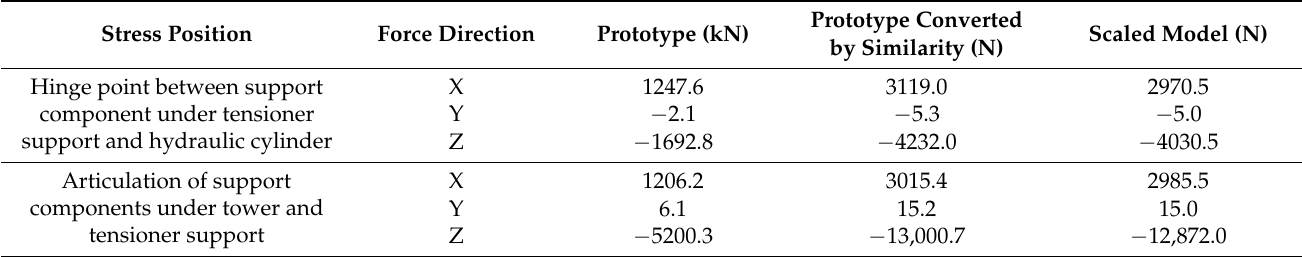
Table A5. Tensioner maximum force during position adjustment.